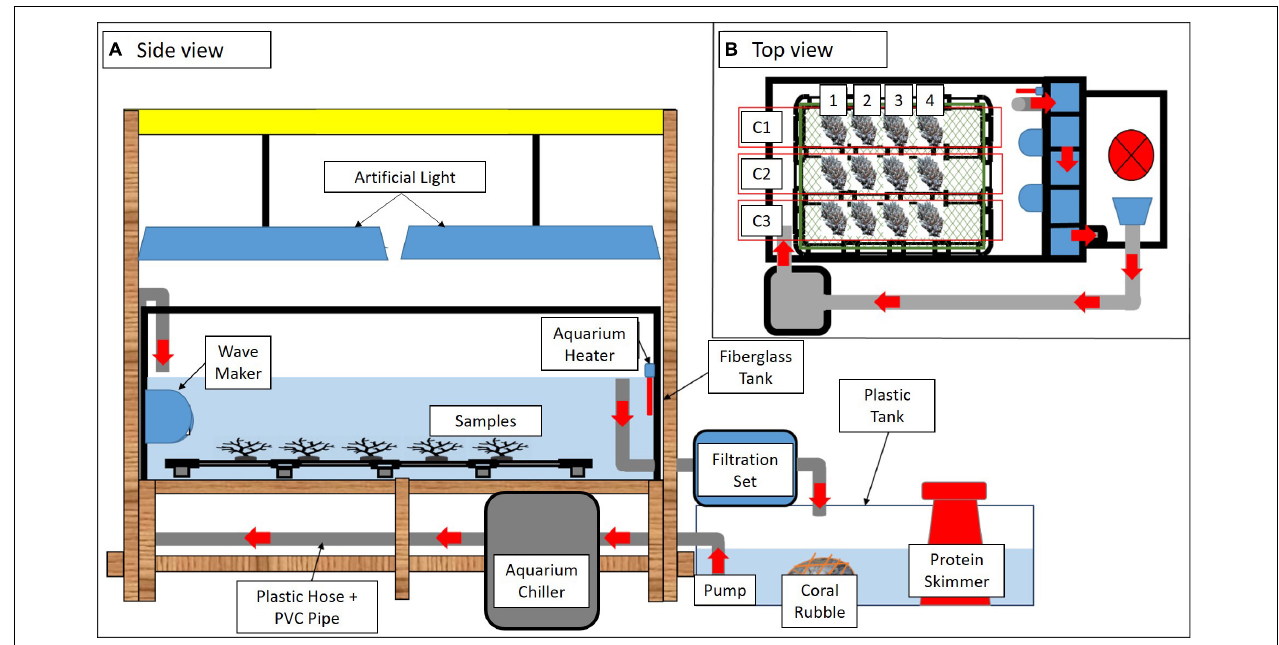
FIGURE 2 | A schematic diagram of the experimental tank set up in different views (A,B) . Red arrows indicate water flow. Three colonies of A. digitifera (C1, C2, and C3) separated into four sub-colonies (1–4) were arranged in each tank (B)